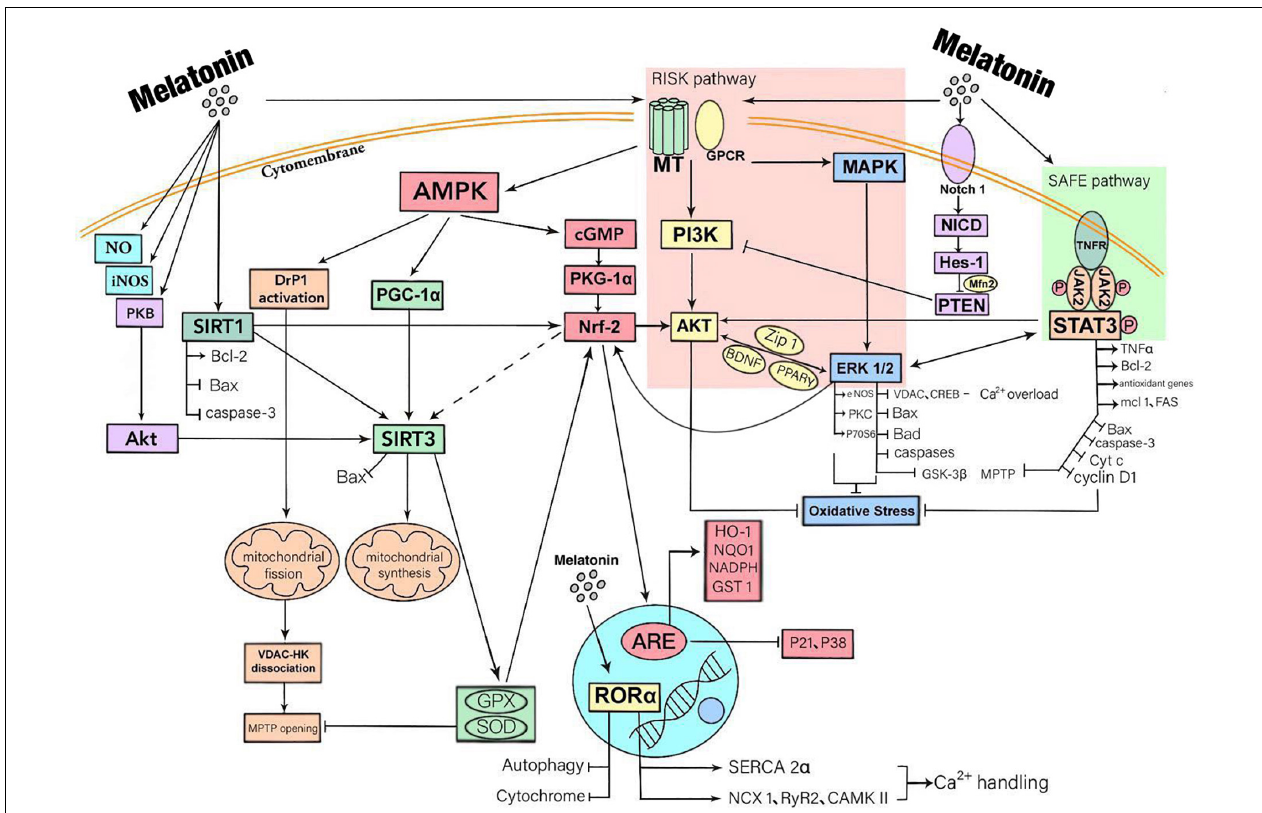
FIGURE 1 | A summary of the mechanisms that myocardial protection mediated by melatonin through receptor and non-receptor pathways. Melatonin has a biological role mainly by being bound to receptors. There are three downstream signal pathways of MT1/2, namely MAPK-ERK signal pathway, AMP-dependent protein kinase (AMPK) signal pathway and PI3K-Akt signal pathway. Melatonin also activates STAT3, a signal transducer and activator of transcription factor for antioxidant enzymes, by activating SAFE pathway. Besides, melatonin activates the Notch1 pathway, thus inhibiting PIK3 function. These downstream signaling molecules are crossed and connected within the cell. In addition, melatonin also enters cells where it has direct biological effects. It promotes the release of NO, enhances the activity of iNOS and boosts the expression of SIRT3 via the activation of PKB-Akt. The ultimate effects of these responses are to reduce oxidative stress, inflammatory responses, and to protect mitochondrial function, thereby reducing cardiomyocyte